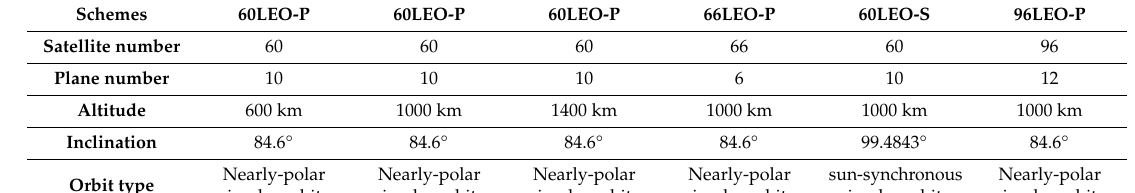
Table 2. Detailed information of the designed LEO constellations.